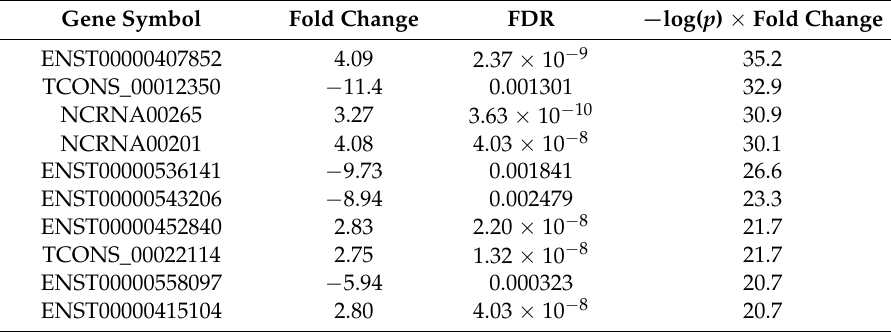
Table 1. Most significant, differentially expressed